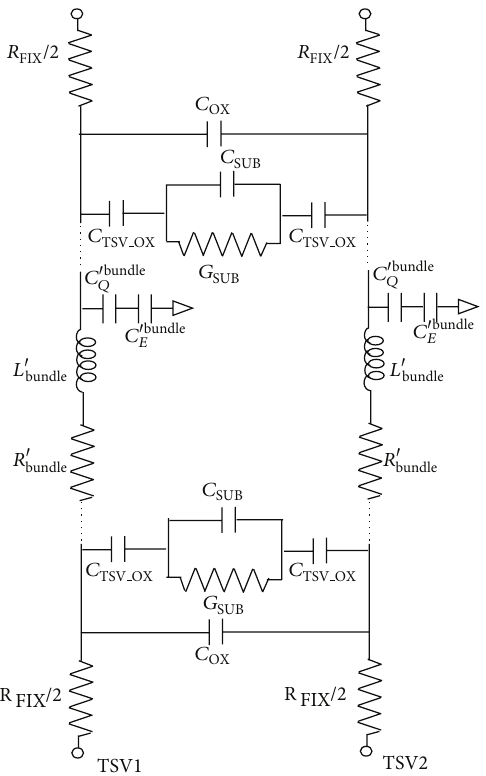
Figure 2: (a) Schematic and (b) physical configuration of a pair of CNT bundle based TSVs. Figure 3: Equivalent electrical model of a pair of CNT bundle based